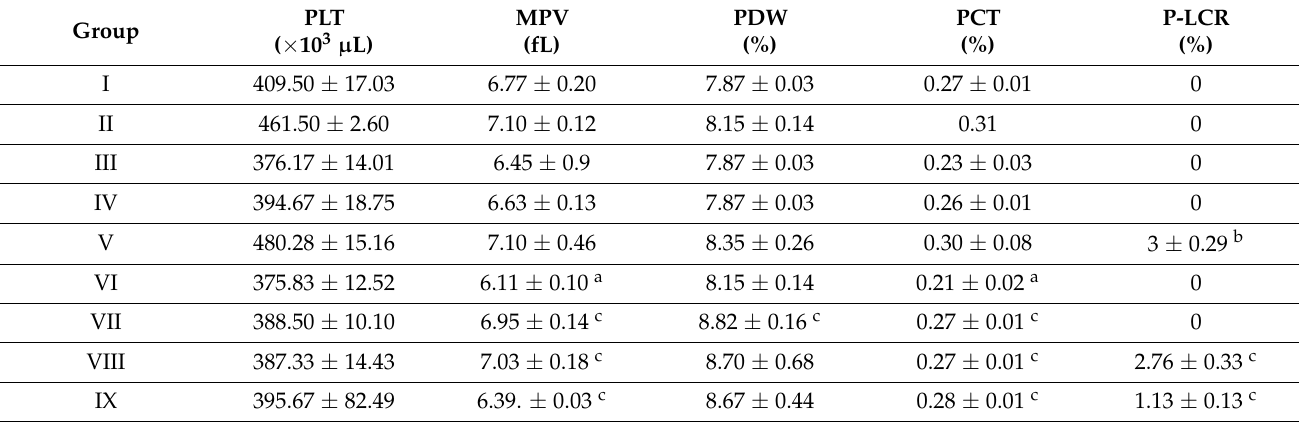
Table 6. Changes in platelets and their indices of mice after two weeks of the